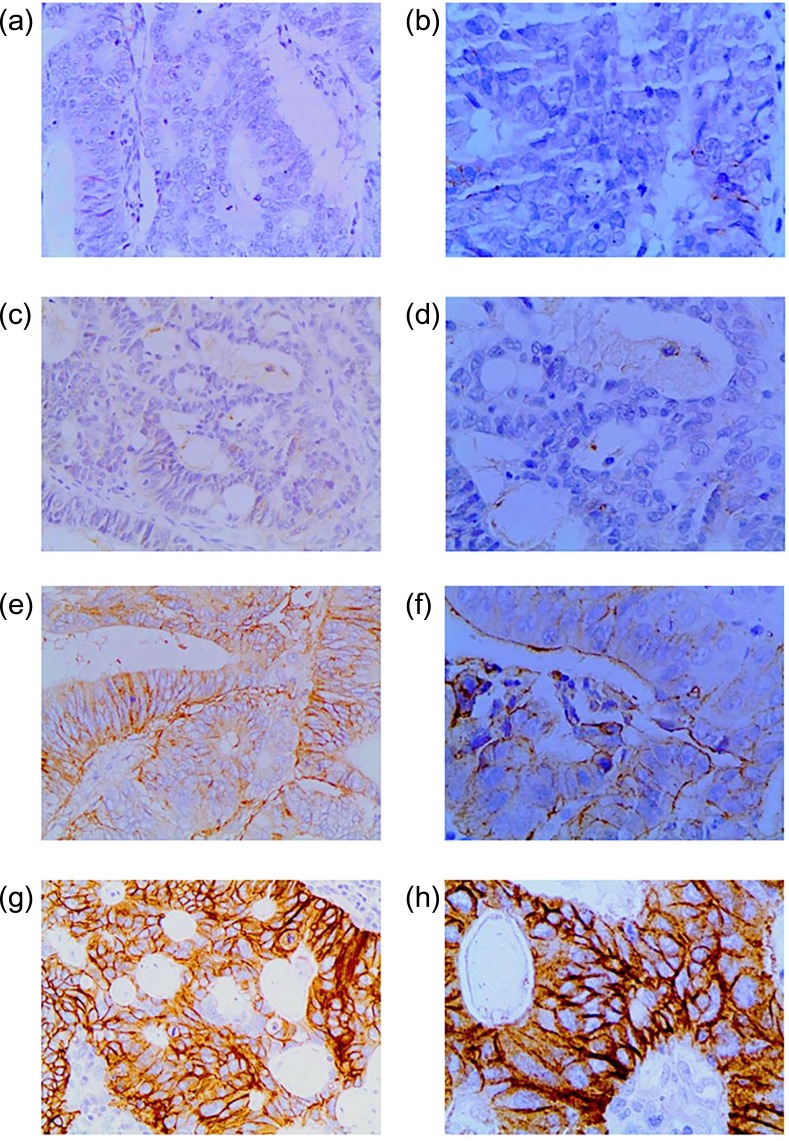
Representative photomicrographs of CD44v6 expression scoring in LARC tissues. CD44v6 is expressed in the cytoplasm. (a) ‘–’ expression (×200). (b) ‘–’ expression (×400). (c) ‘+’ expression (×200). (d) ‘+’ expression (×400). (e) ‘++’ expression (×200). (f) ‘++’ expression (×400). (g) ‘+++’ expression (×200). (h) ‘+++’ expression (×400).